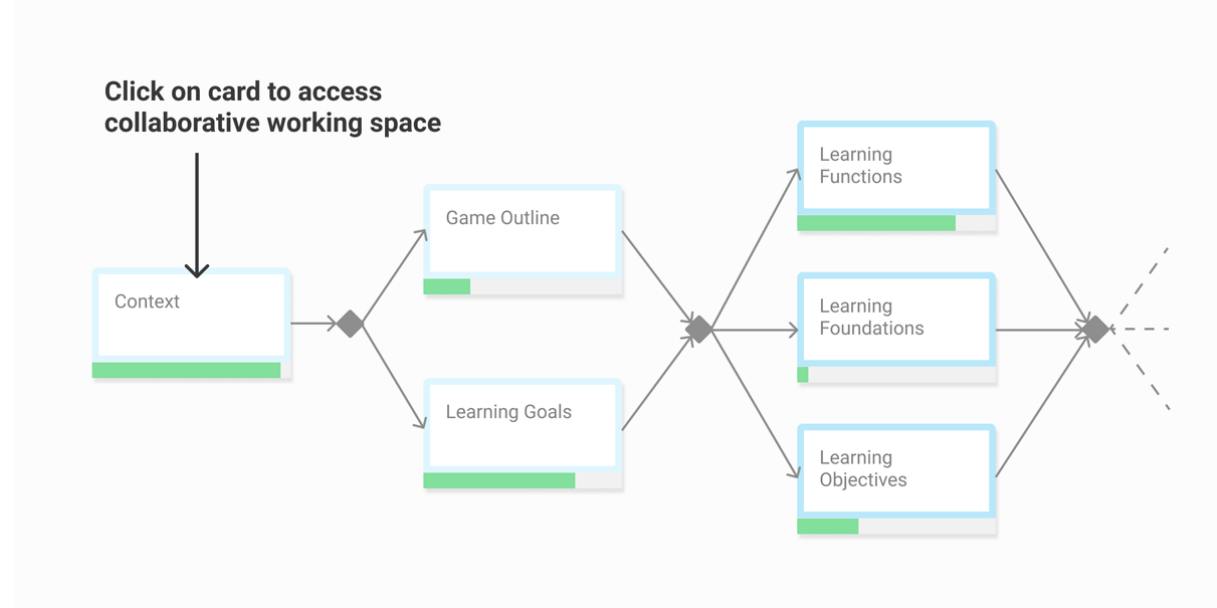
Figure 5. Activity network diagram view, emphasizing precedence dependency